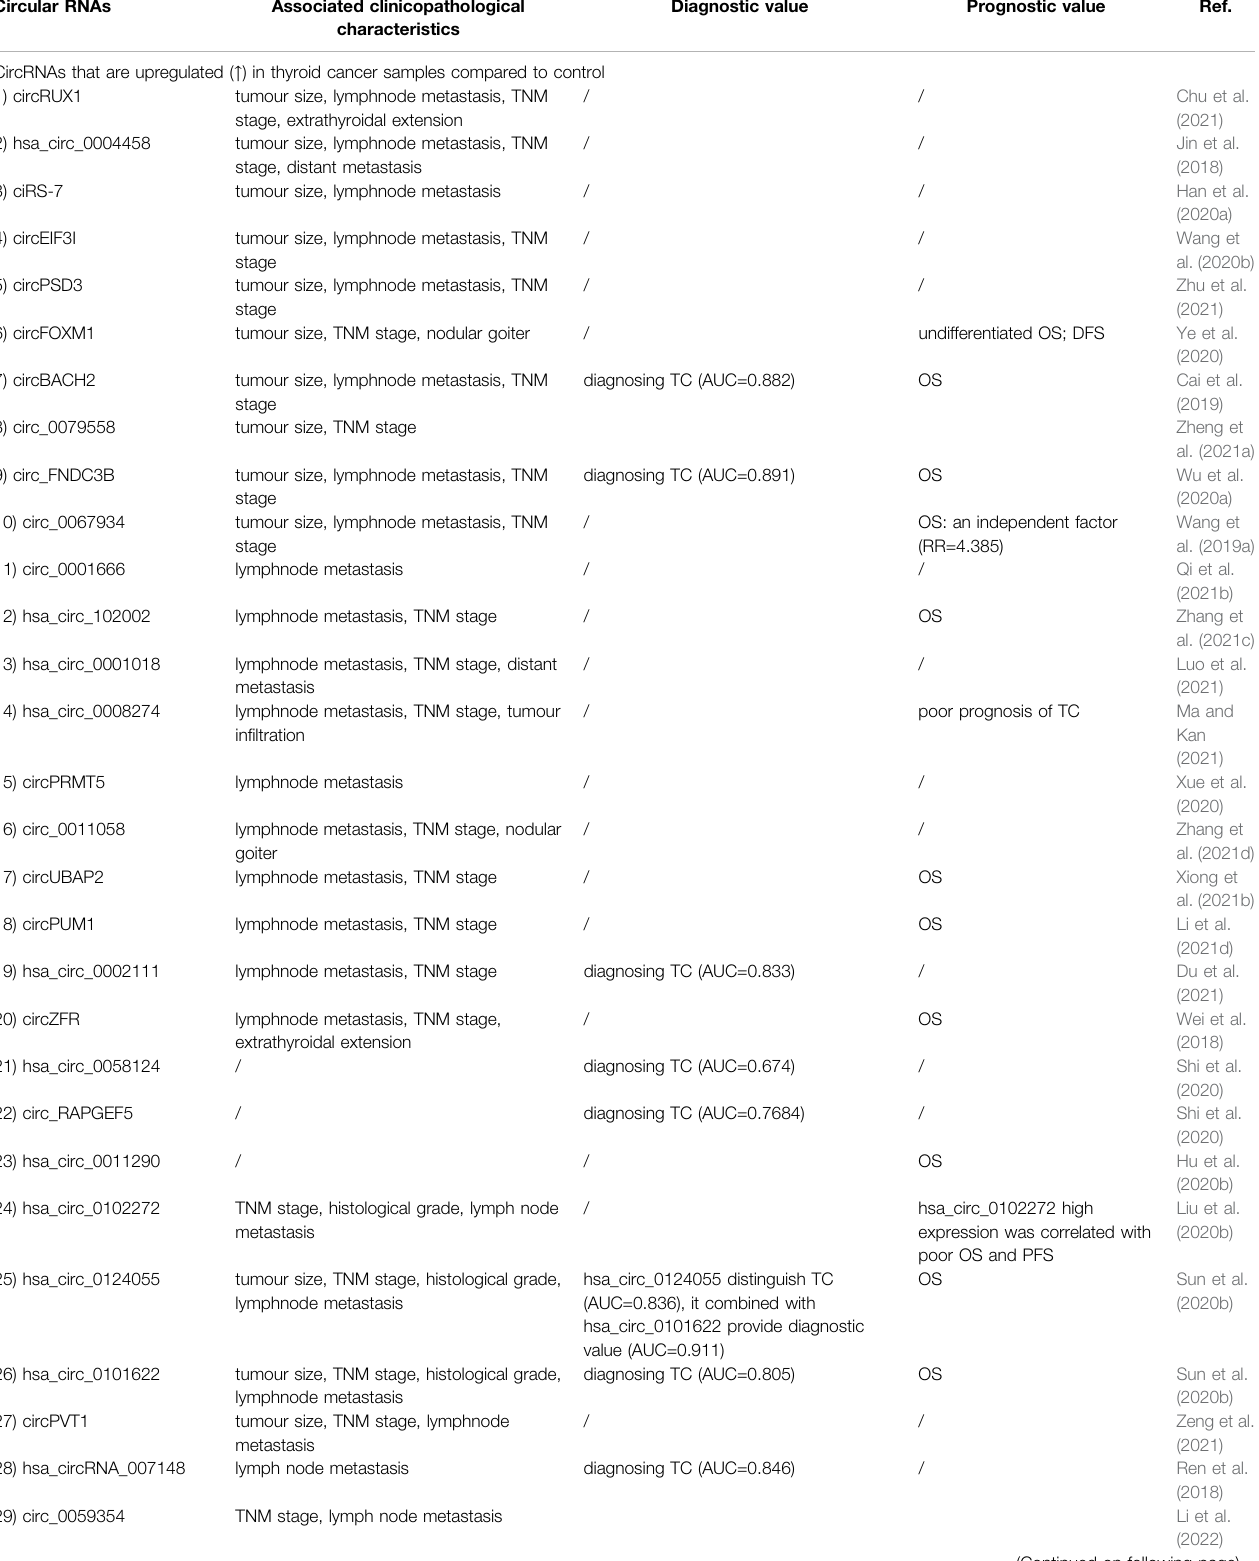
TABLE 2 | Clinical signi fi cance of dysregulated circRNAs in thyroid cancer. Circular